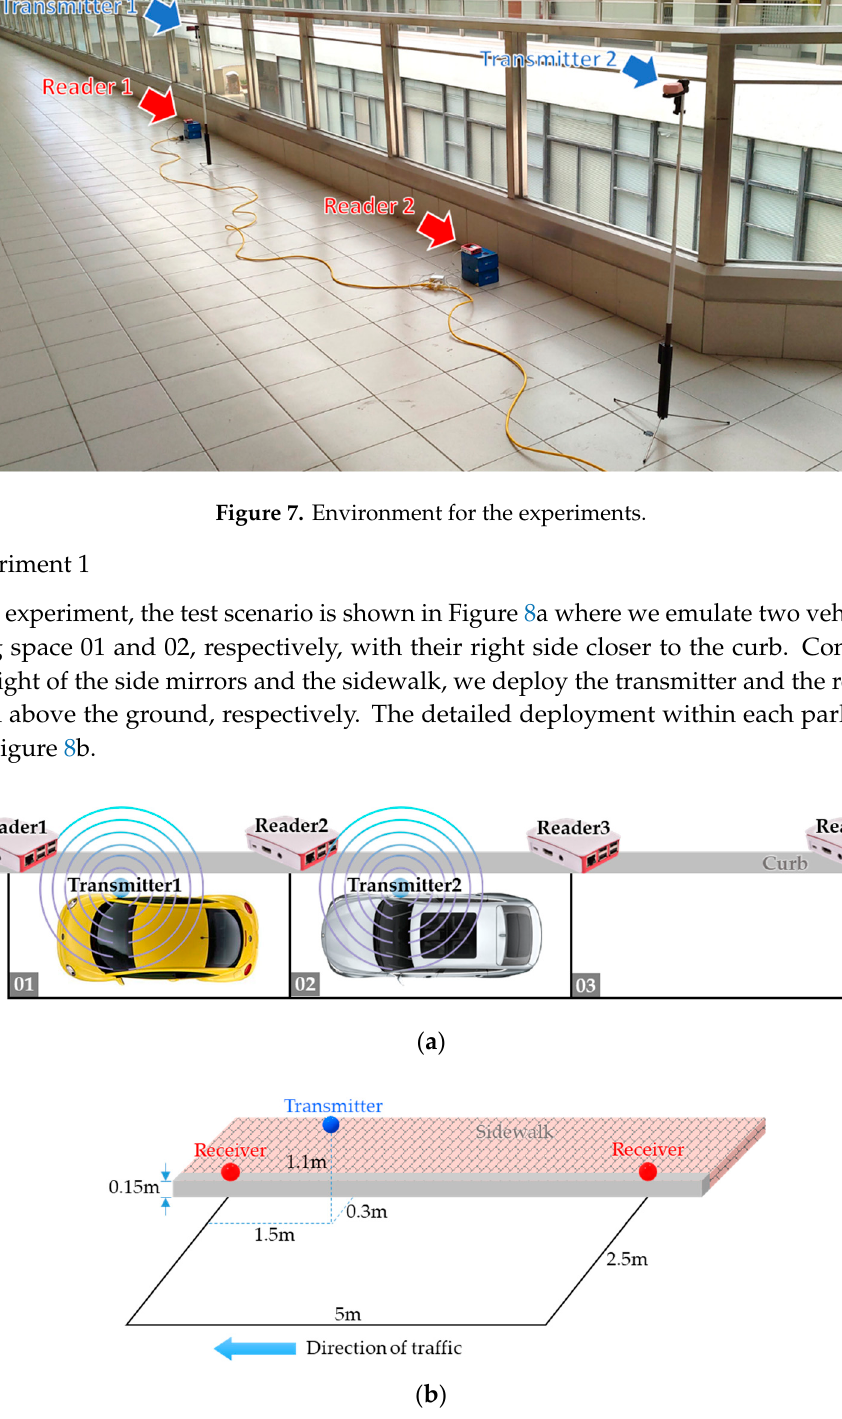
Figure 8. Experiment 1: ( a ) test scenario, ( b ) detailed deployment within each parking space.